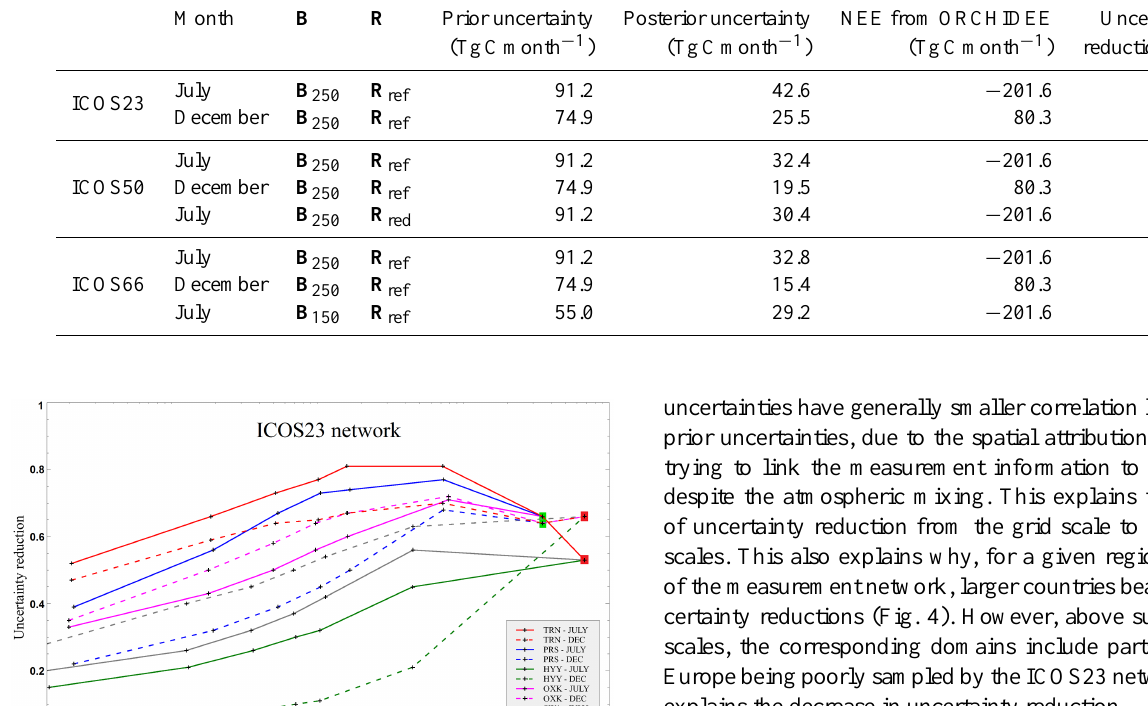
Table 1. Uncertainty reduction in a 2-week- and European-mean NEE for July and December as a function of the observation network and of the configuration of the inversion parameters ( B 250 or B 150 for B and R ref or R red for R ). Prior uncertainty Posterior uncertainty NEE from ORCHIDEE Uncertainty